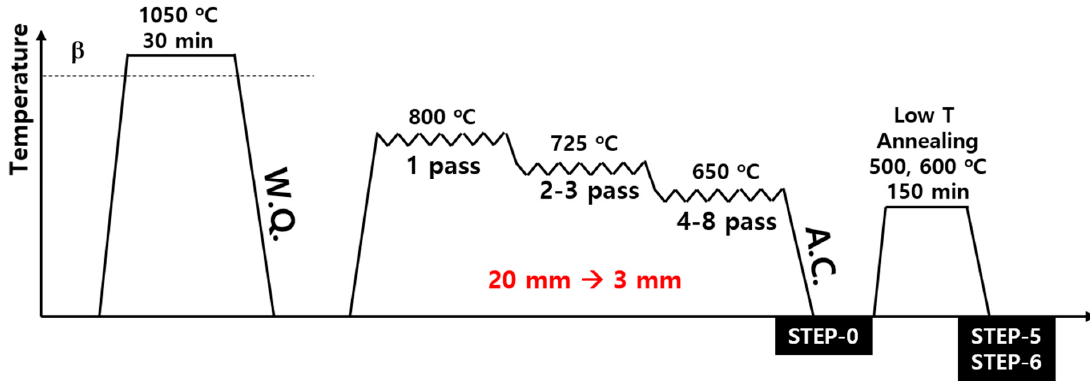
Figure 1. Schematic illustration of the step rolling and subsequent annealing employed in this work. An RT tensile test was performed at a strain rate of 5 × 10 − 3 s − 1 using a universal mechanical testing machine (8801, INSTRON, Norwood, MA, USA) with an extensometer (3542-025M-100-ST, Epsilon, Jackson, WY, USA), based on the procedure of the ASTM-E8 standard. Plate-type tensile specimens with a gage length of 25 mm, width of 6 mm, and thickness of 3 mm were machined along